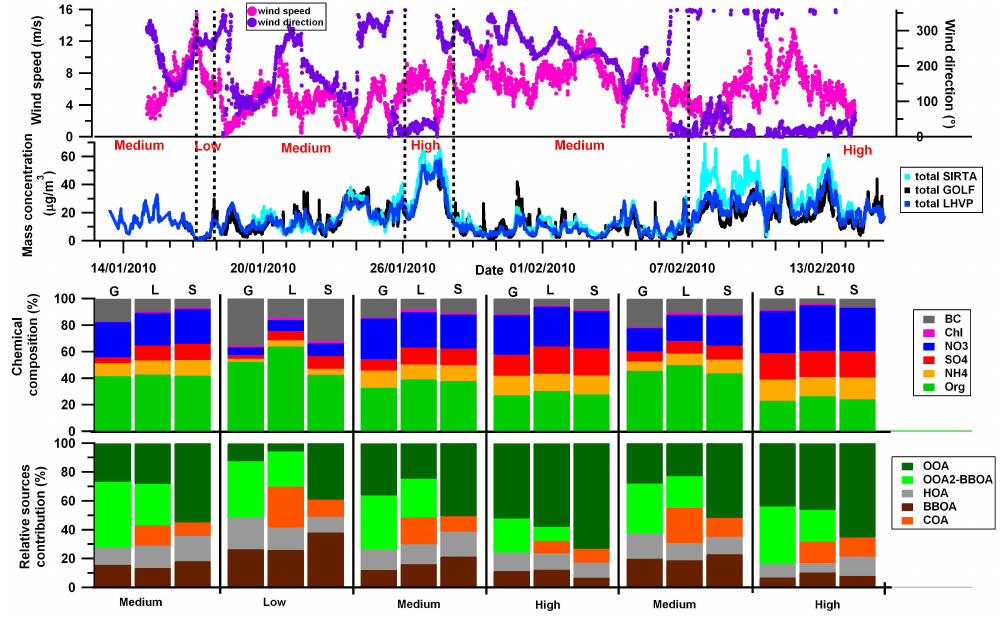
Fig. 12. Temporal variation of the chemical composition and organic source apportionment for different wind sectors and mass concentrations (G = GOLF site, L = LHVP site, S = SIRTA site). The total mass is the sum of the AMS species and BC measurements (blue